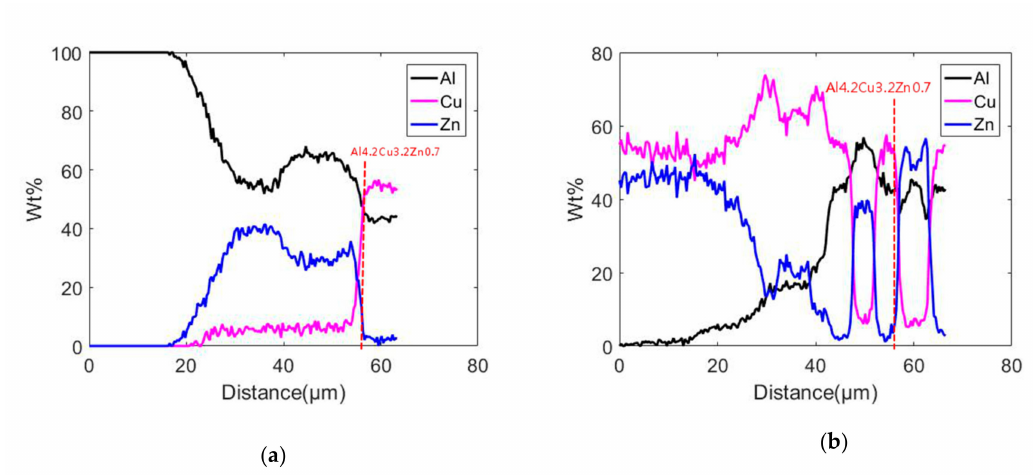
Figure 7. Results of line scanning on copper and aluminum sides. ( a ) Line scan of Al side. ( b ) Line scan of Cu